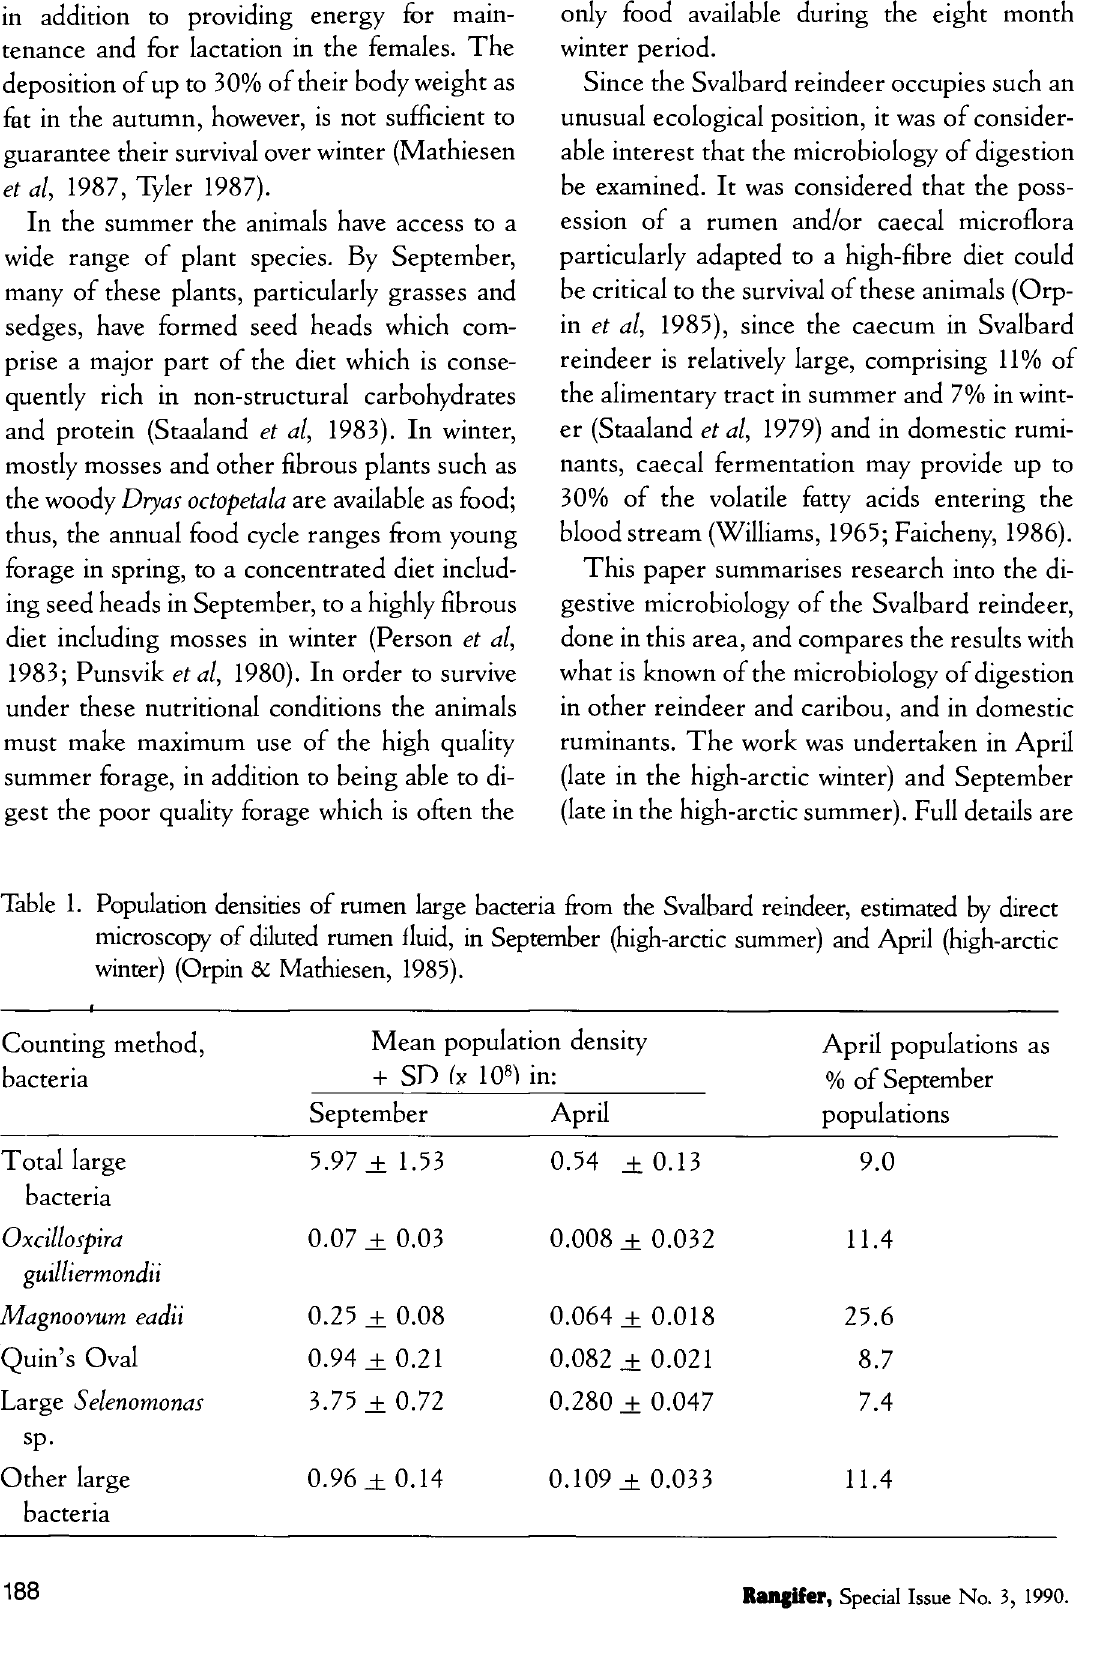
Table 1. Population densities of rumen large bacteria from the Svalbard reindeer, estimated by direct microscopy of diluted rumen fluid, in September (high-arctic summer) and April (high-arctic winter) (Orpin & Mathiesen,